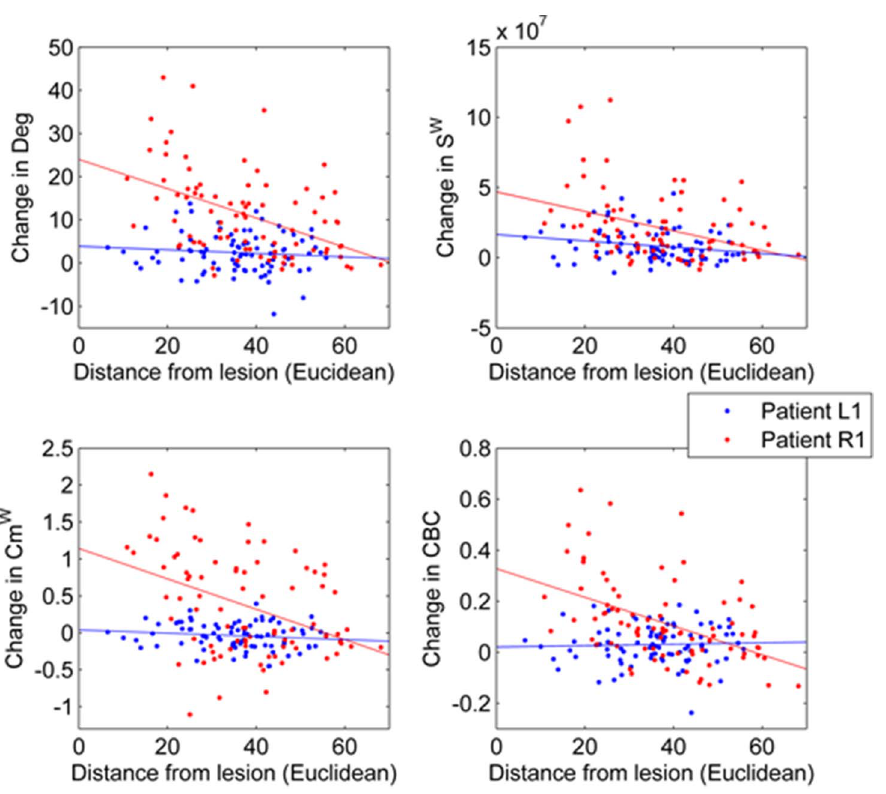
Fig. 7. Local correlations between changes ((A) Deg, (B) S w (C) Cm w (D) CBC) from the control group and distance from lesion for stroke patient L1 (largest lesion) and R1 (smallest lesion). Crosses indicate local values for patient L1, while dots are associated to local values of patient R1. Lines indicate the least square lines associated to each